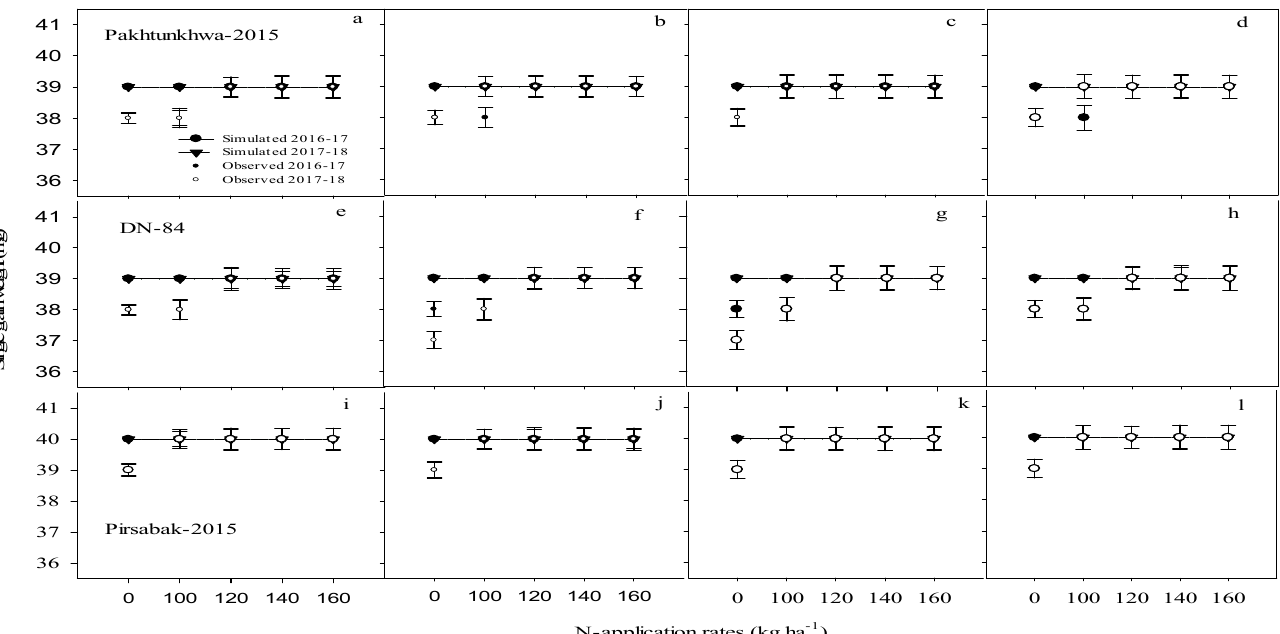
Figure 4. Using CSM-CERES-Wheat to predict single grain weight (mg) as a function of N application at different stages: full N application (N 100% ) at sowing ( a , e , i graphs), half of recommended N application (N 50% ) at sowing + N 50% at tillering ( b , f , j graphs), quarter of recommended N application (N 25% ) at sowing + N 50% at tillering + N 25% at booting ( c , g , k graphs), and N 25% at sowing + N 25% at tillering + N 50% at booting stage ( d , h , l graphs) for different cultivars.